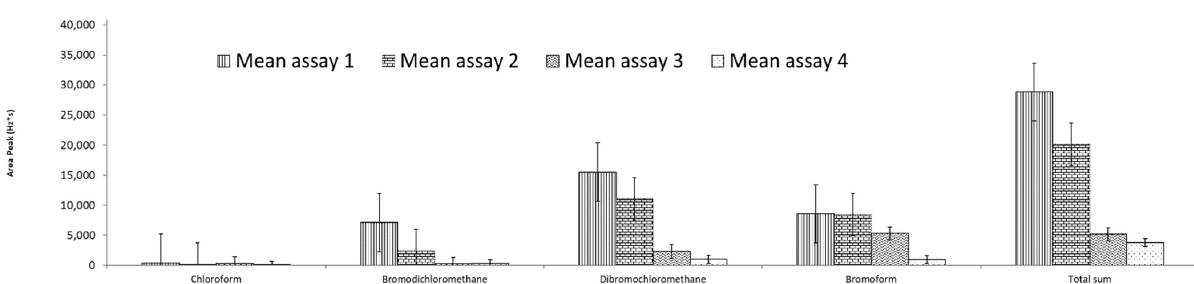
Figure 8. CRD design for desorption time optimization after HS-SPME under sonication with 5 mL of methanol showing the four times assayed and its replicates under the best extraction conditions (13th trial).